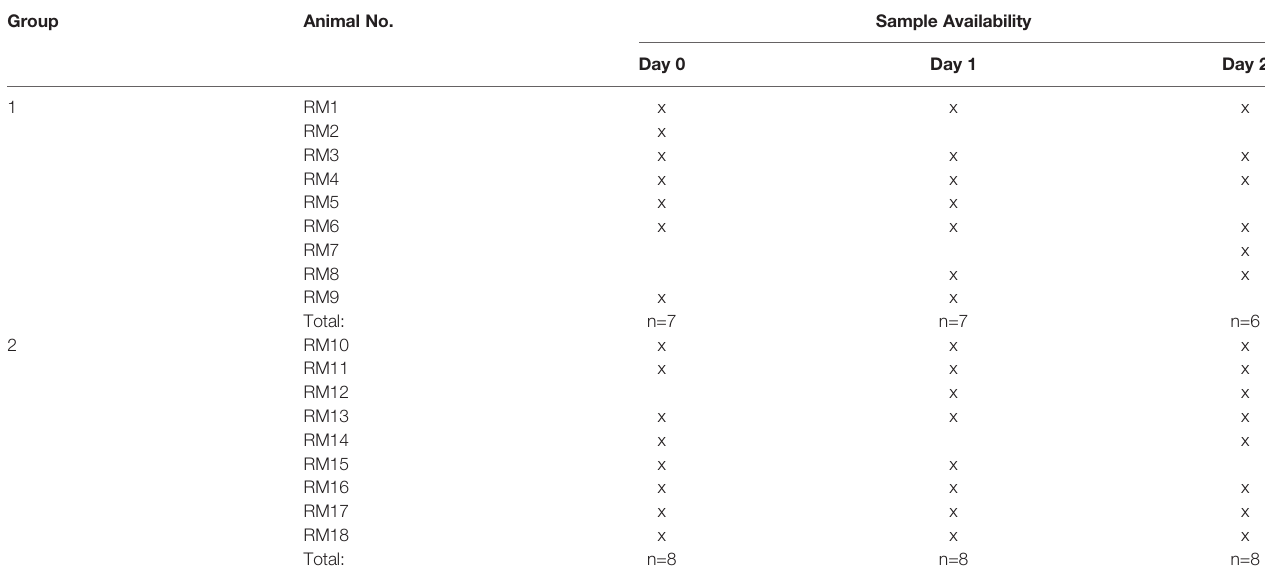
TABLE 1 | List of animals and samples for transcriptome analysis. Group Animal